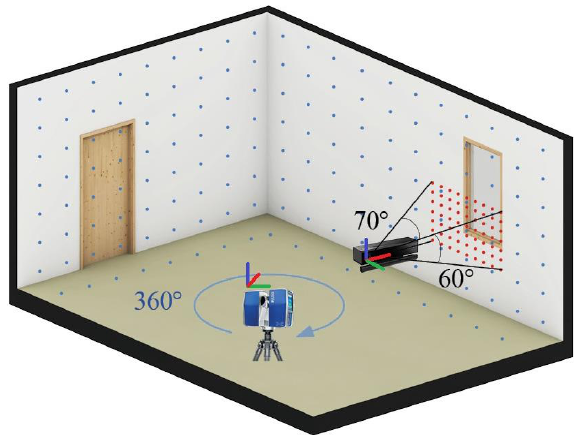
Figure 4. Simplified schema of acquisition protocol